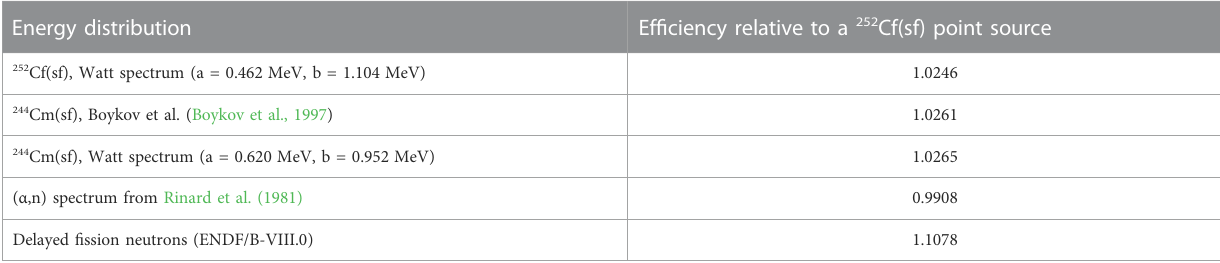
TABLE11Detectionef fi ciencyfor(sf)and( α ,n)neutrons,delayed fi ssionneutronsfrom 244 Cm(sf)andprompt fi ssionneutronsduetoneutroninduced fi ssioninthe SNFsamplerelativetothedetectionef fi ciencyforprompt fi ssionneutronsfroma 252 Cf(sf)pointsource.Theuncertaintiesduetothesimulatednumberofhistories are smaller than the last signi fi cant